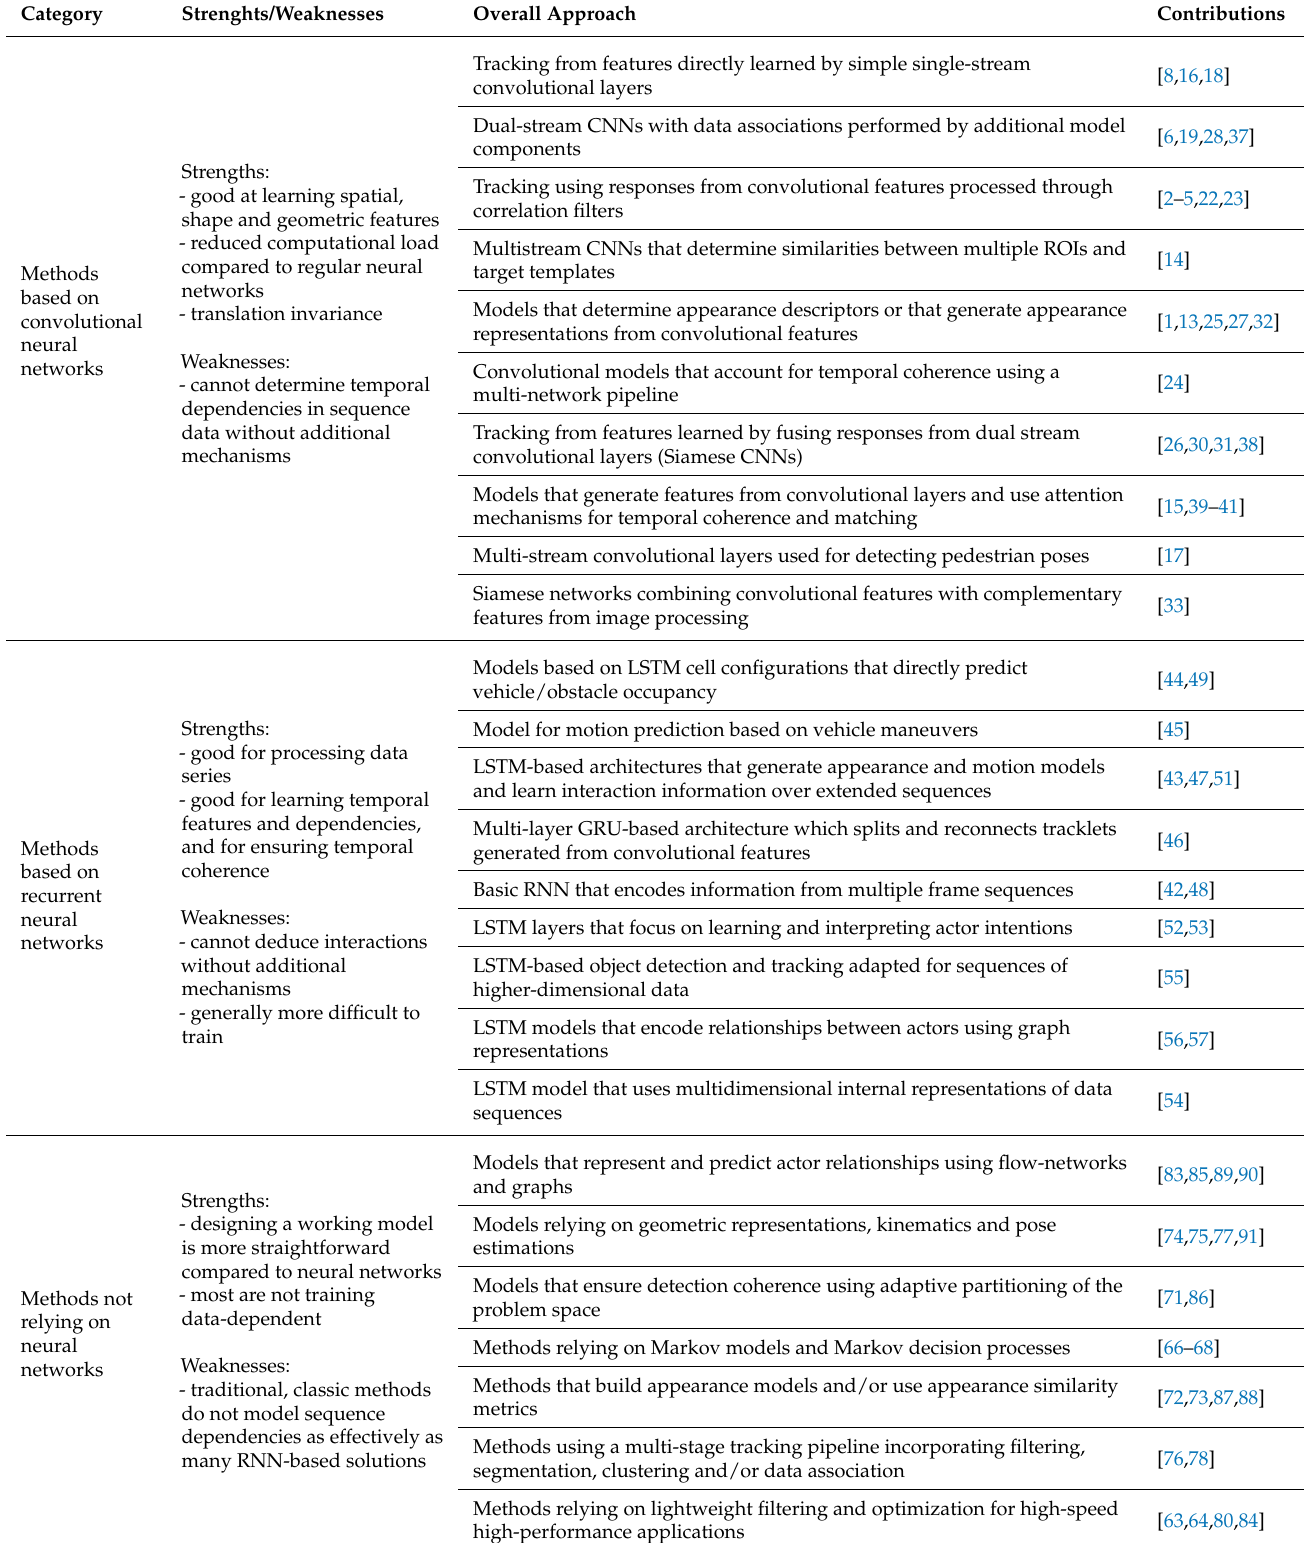
Table 1. Classification of tracking solutions from existing